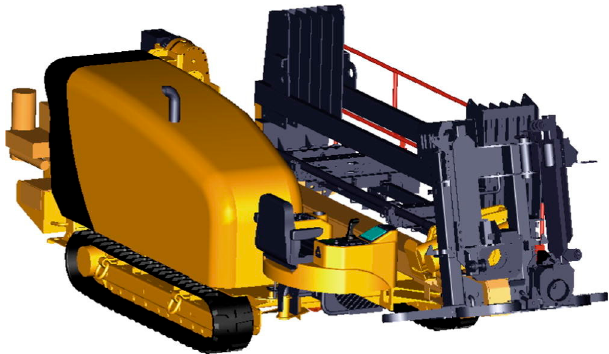
Figure 2. Description of the G + , G , and G − . FM: failure mode.